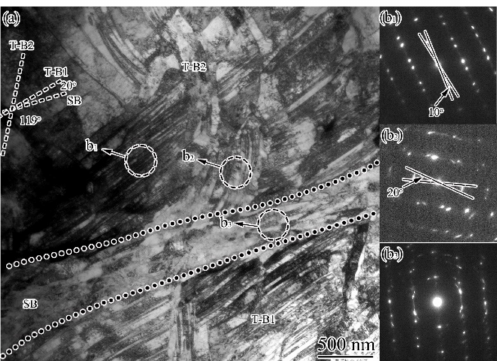
Figure 8. TEM observation ( a ) and the corresponding SAED patterns ( b 1 – b 3 ) for the SBs within FTS in USRT AISI 304 stainless steel sample. Circles indicate the areas where the SAED patterns were obtained.